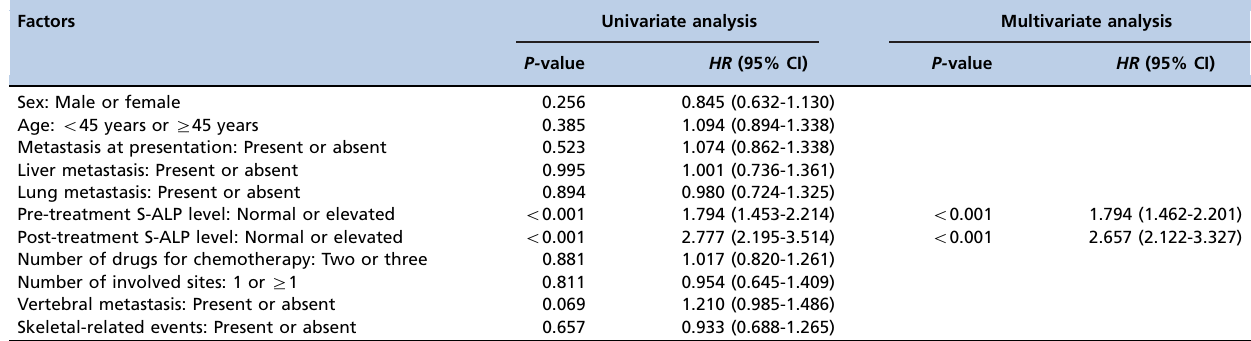
Table 3 - Univariate and multivariate analysis of overall survival. Factors Univariate